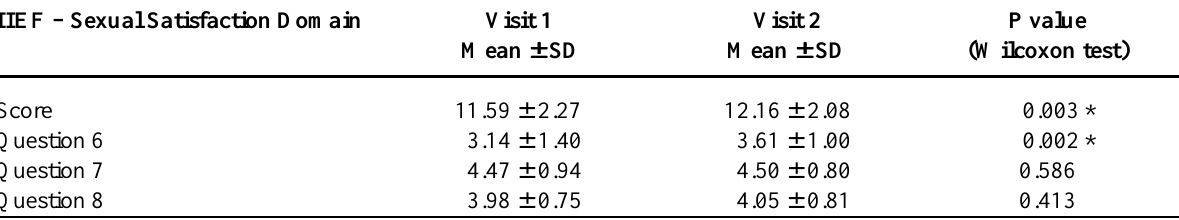
Table 2 – Score and questions related to the sexual satisfaction domain of the IIEF on visits 1 and 2 (n =